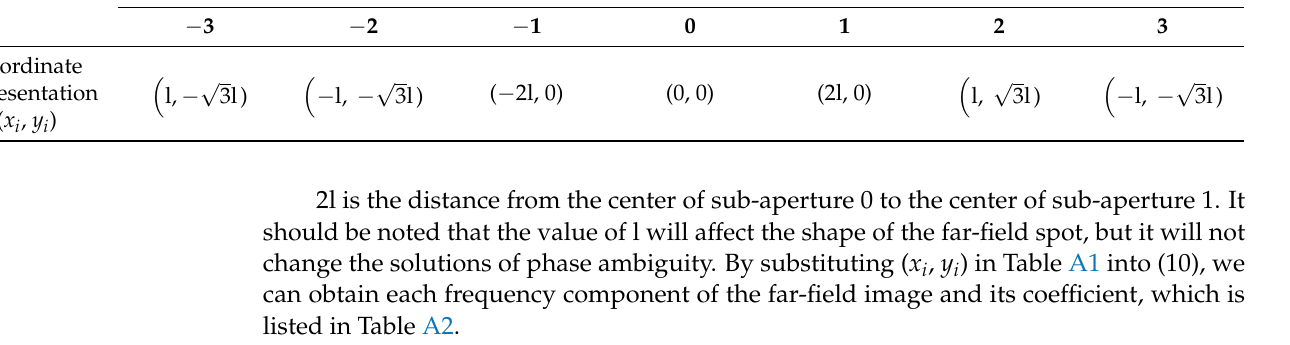
I generated by Φ far